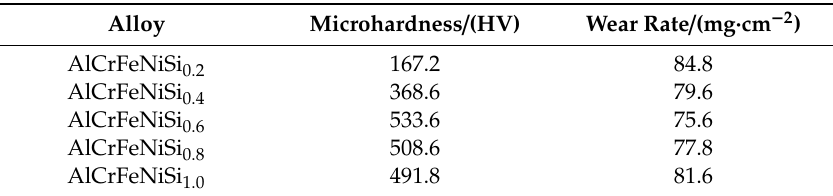
Table 3. Alloy hardness and rate of